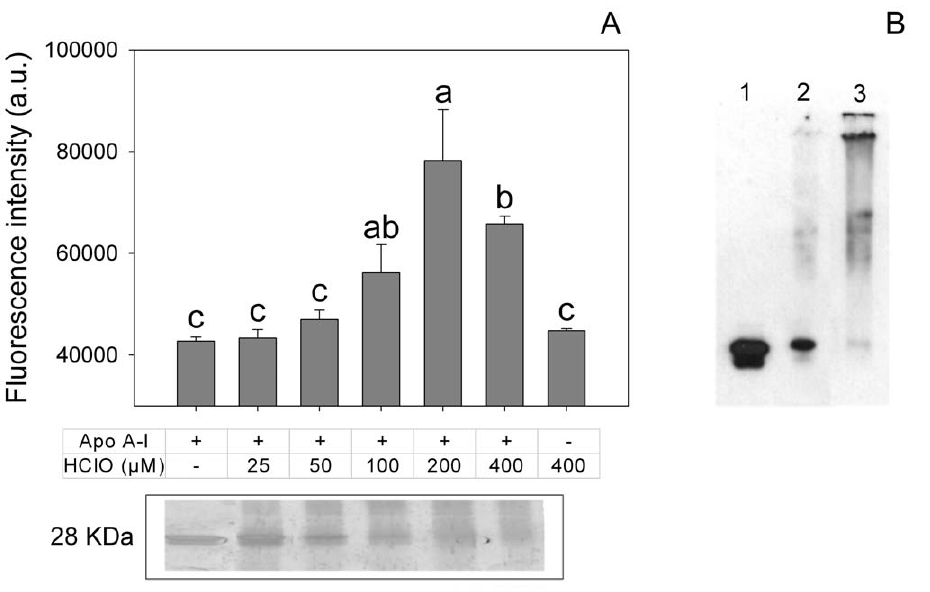
Figure 7. Effect of HClO on apoA-I processing and amyloidogenicity. ApoA-I (0.2 mg/mL) was incubated at increasing concentrations of HClO (as indicated) for 60 min at room temperature. (A) An aliquot (20 m l) of each sample was resolved on SDS-PAGE and silver stained. Control, non- modifed apoA-I is shown in the first lane (lower panel). Another aliquot was further incubated at 37 u C for 24 h and ThT binding was measured (upper panel). Bars correspond to means 6 SE. Bars denoted by different letters differ significantly at p , 0.05. (B) Western blotting (against apoA-I as indicated in Fig. 5) of HClO-treated apoA-I samples. Lanes 1 to 3 correspond to apoA-I incubated with 0, 25 and 200 m M HClO, respectively.